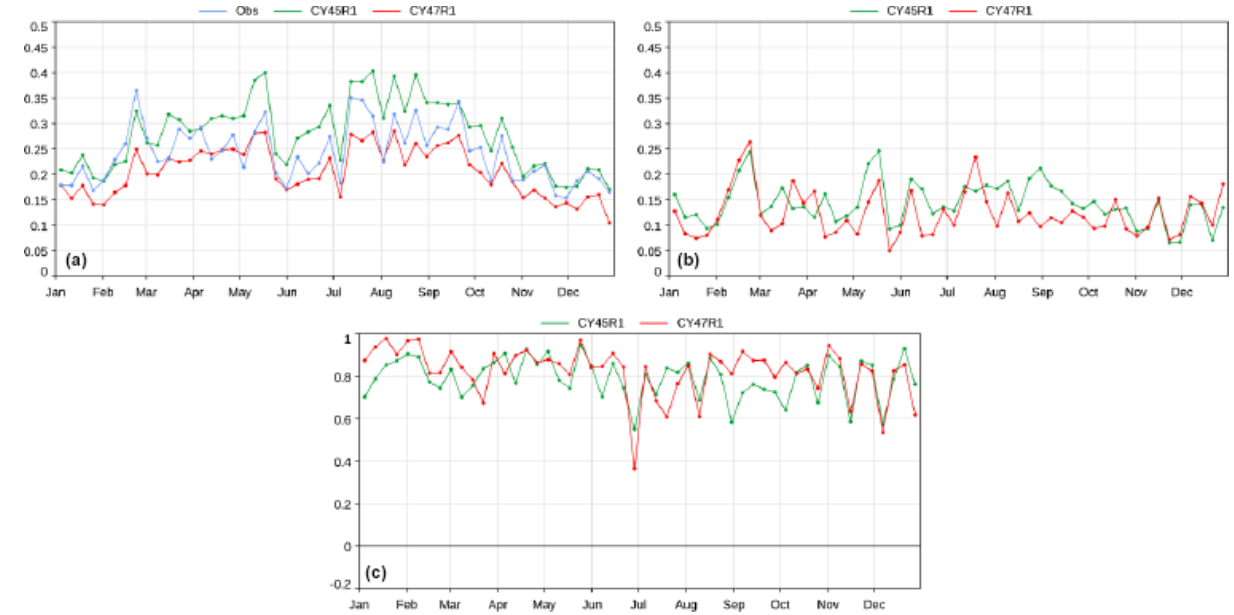
Figure 10. (a) Observed and simulated weekly averaged AOD in 2017 over a selection of 24 AERONET stations more representative of desert conditions. (b) RMSE of simulated AOD against AERONET AOD at these 24 stations. (c) Spatial correlation between simulated and observed AOD at 500nm. The AERONET stations used in this plot are: Tizi Ouzou, Tamanrasset INM, Sede Boker, Mezaira,